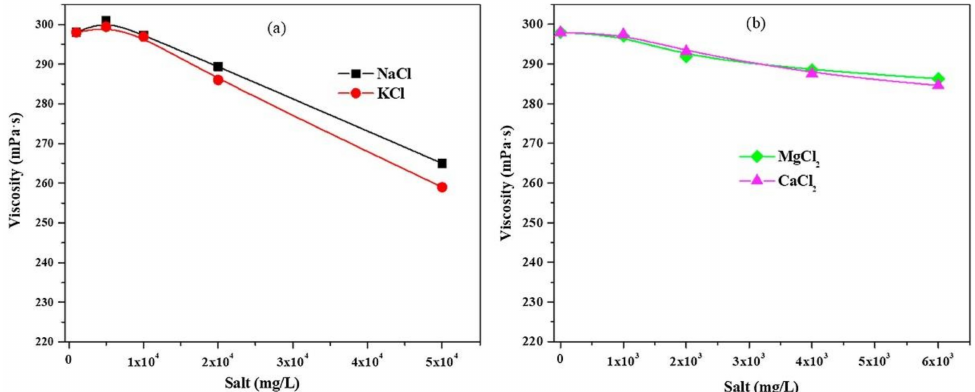
Figure 14. Shear viscosity of a 3% EA solution with inorganic salts: ( a ) KCl and NaCl are monovalent salts; ( b ) MgCl 2 and CaCl 2 are divalent salts